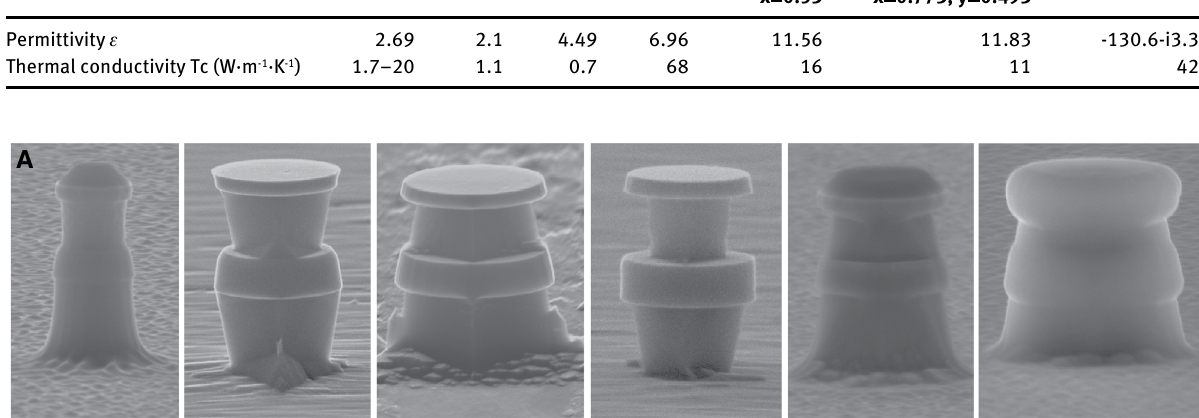
PO etching alone, (C) after HCl:CH 3 4